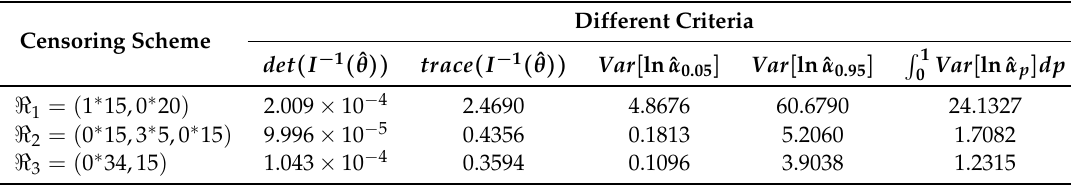
Table 26. Comparision of censoring schemes using different